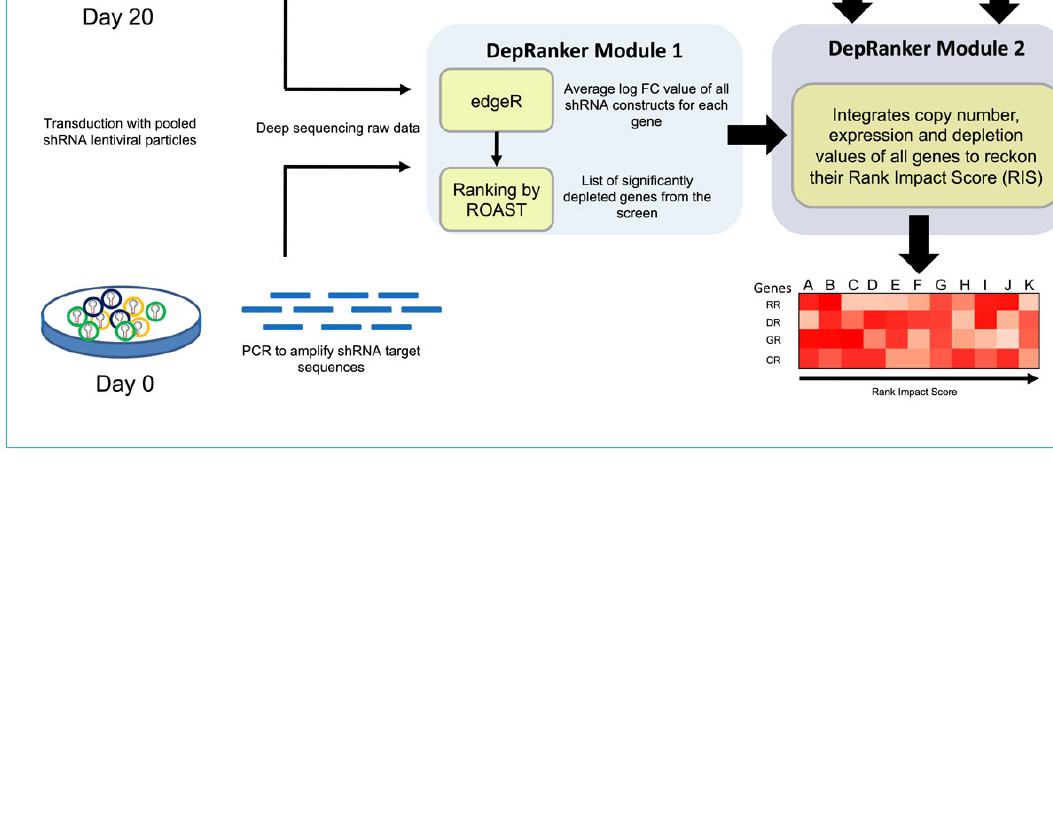
Table S2: ROAST ranking of all the depleted kinases in Table S3: Integrated copy number, gene expression and